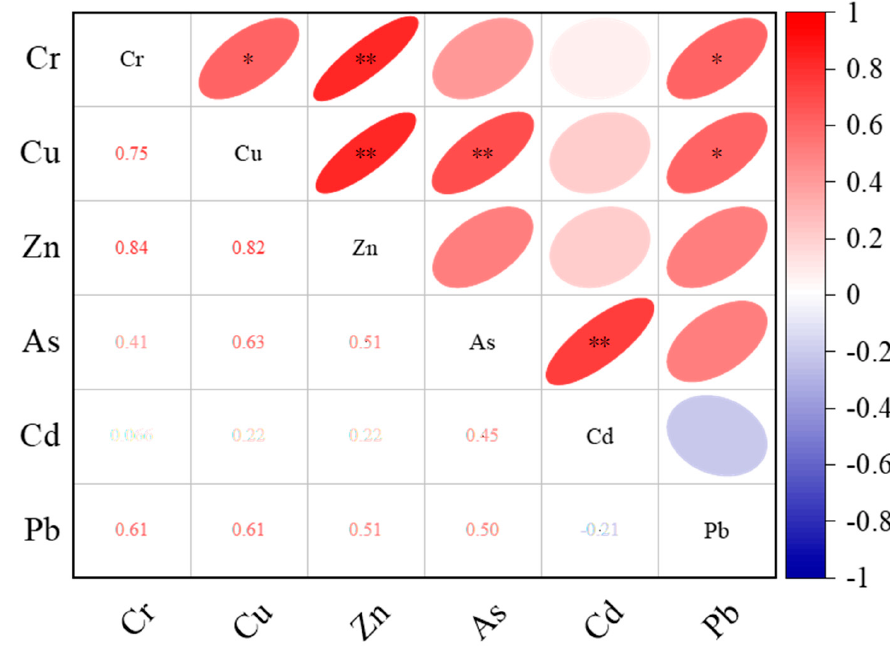
Figure 5. Pearson correlation coefficients among heavy metals (** p < 0.01, * p < 0.05).